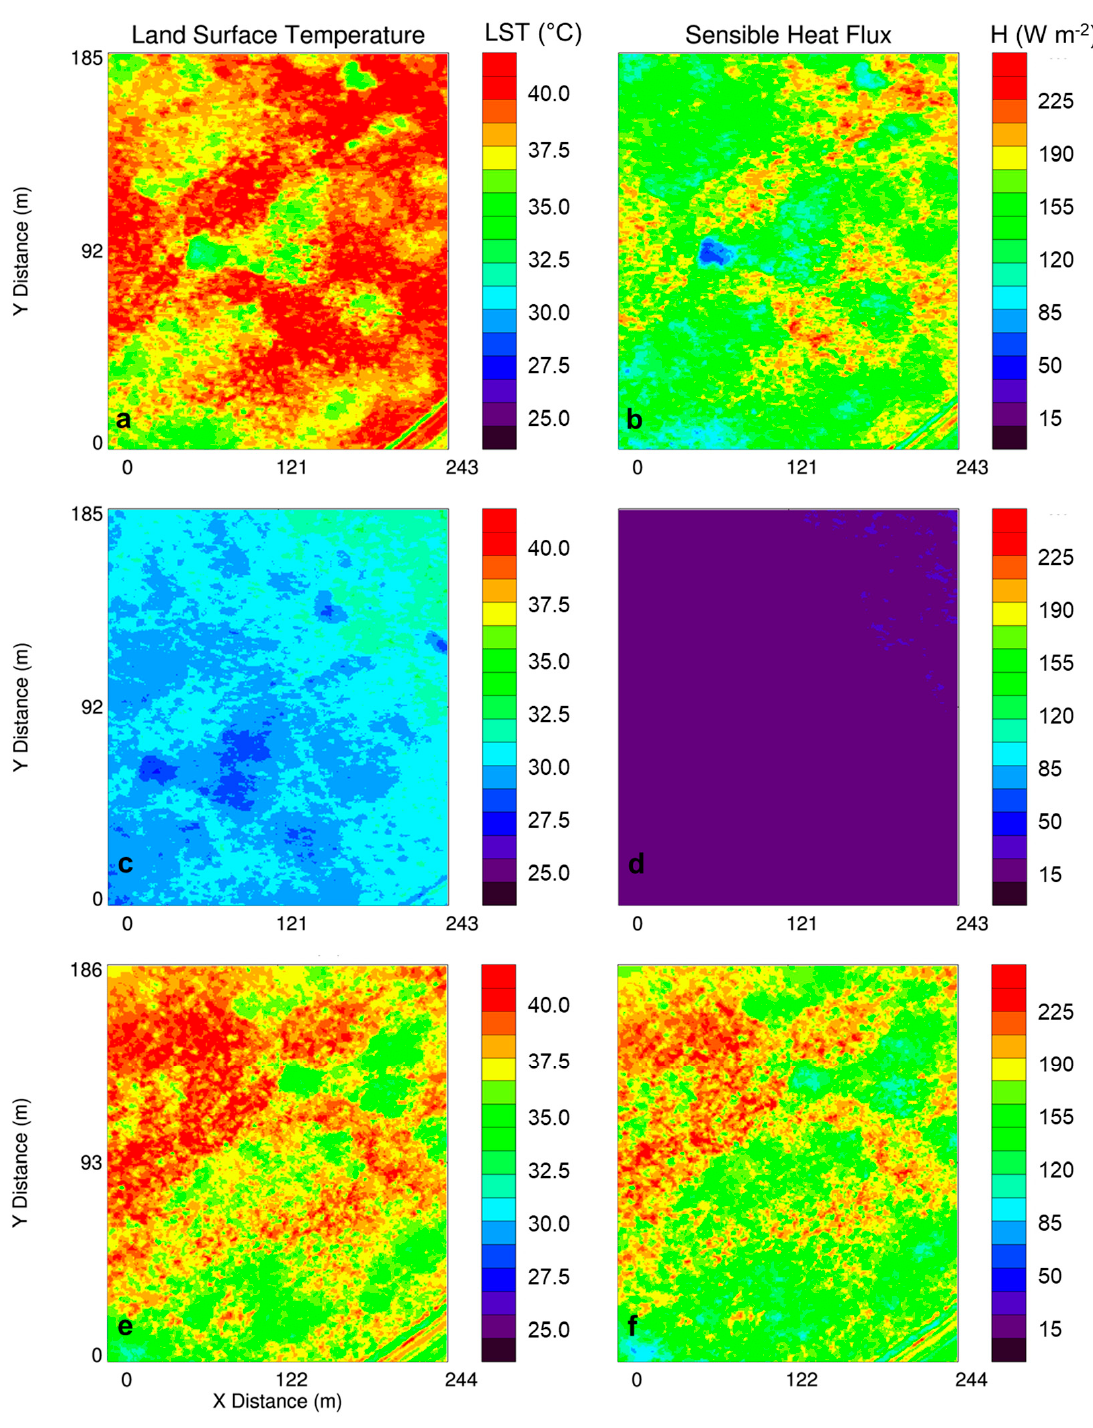
Figure 9. Land-surface temperature (LST) ( a ) and surface sensible heat flux ( b ) at 20:24 UTC on 14 August 2017, sampled from the downward-pointing IR camera on the DJI S-1000 sUAS while flying at a constant altitude of 300-m AGL. Same for panels ( c ) and ( d ), and for panels ( e ) and ( f ), but at 20:16 UTC 15 August 2017, and 20:16 UTC 17 August 2017, respectively. The same region is shown in all six panels .